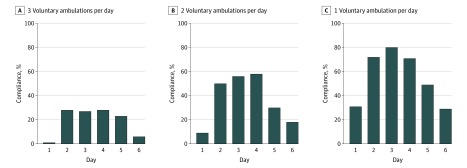
Compliance With Number of Completed Voluntary Ambulations per DayA-C, Graphs show data for 3 voluntary ambulations per day (A), 2 voluntary ambulations per day (B), and 1 voluntary ambulation per day (C). The mean (SD) length of stay was 5.9 (2.2) days. The total numbers of individuals were 100 at days 1, 2, and 3; 92 at day 4; 73 at day 5; and 47 at day 6. Data are shown for up to day 6 in the cardiac surgery progressive care unit.